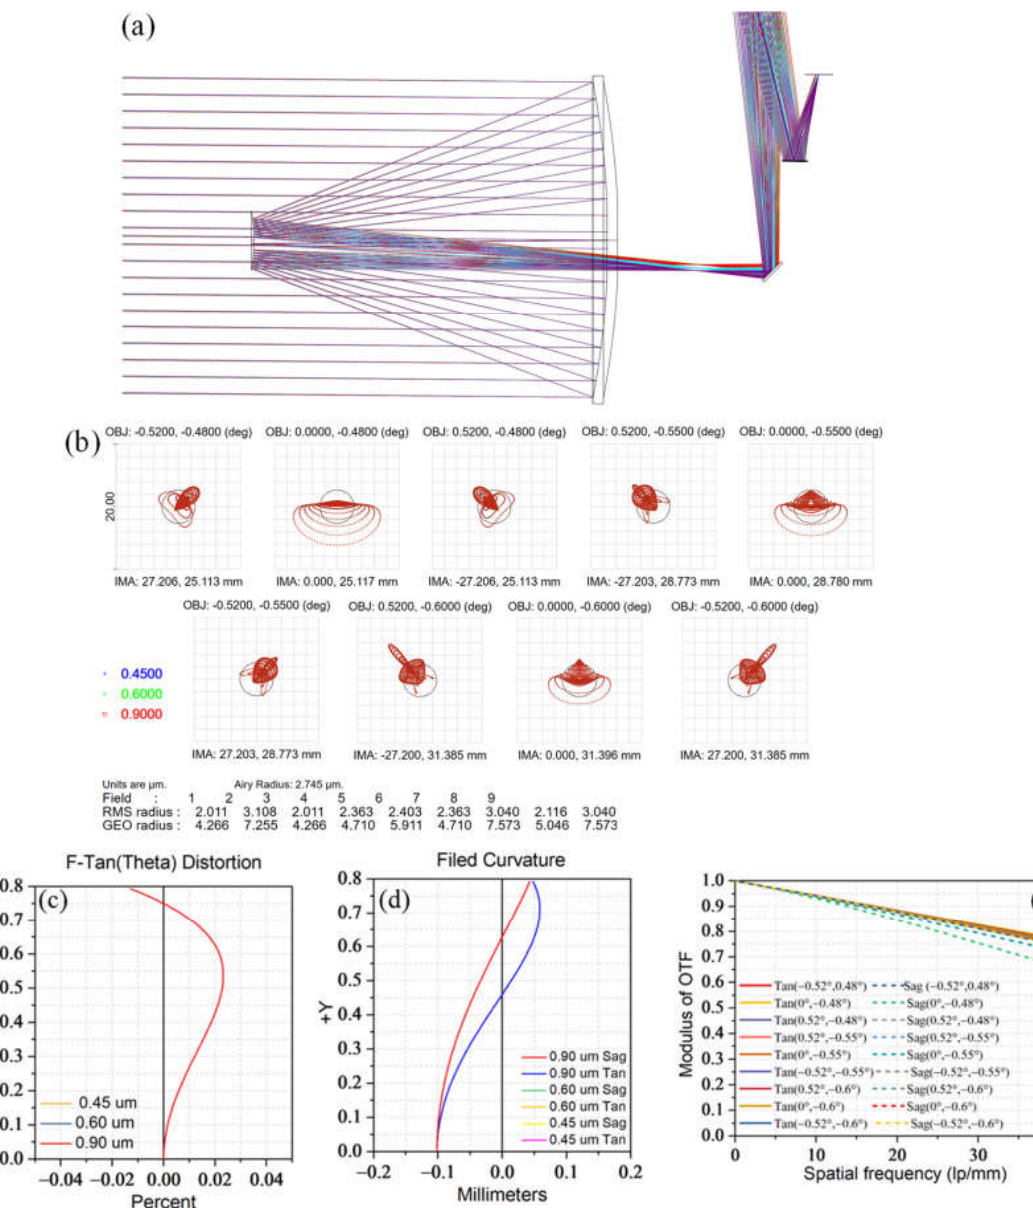
Figure 8. The rear-reflection path 1. ( a ) Optical layout diagram. ( b ) Spot diagram. ( c ) Distortion of the different wavelengths. ( d ) Field curvature of the different wavelengths. ( e ) Modulation transfer function diagram.